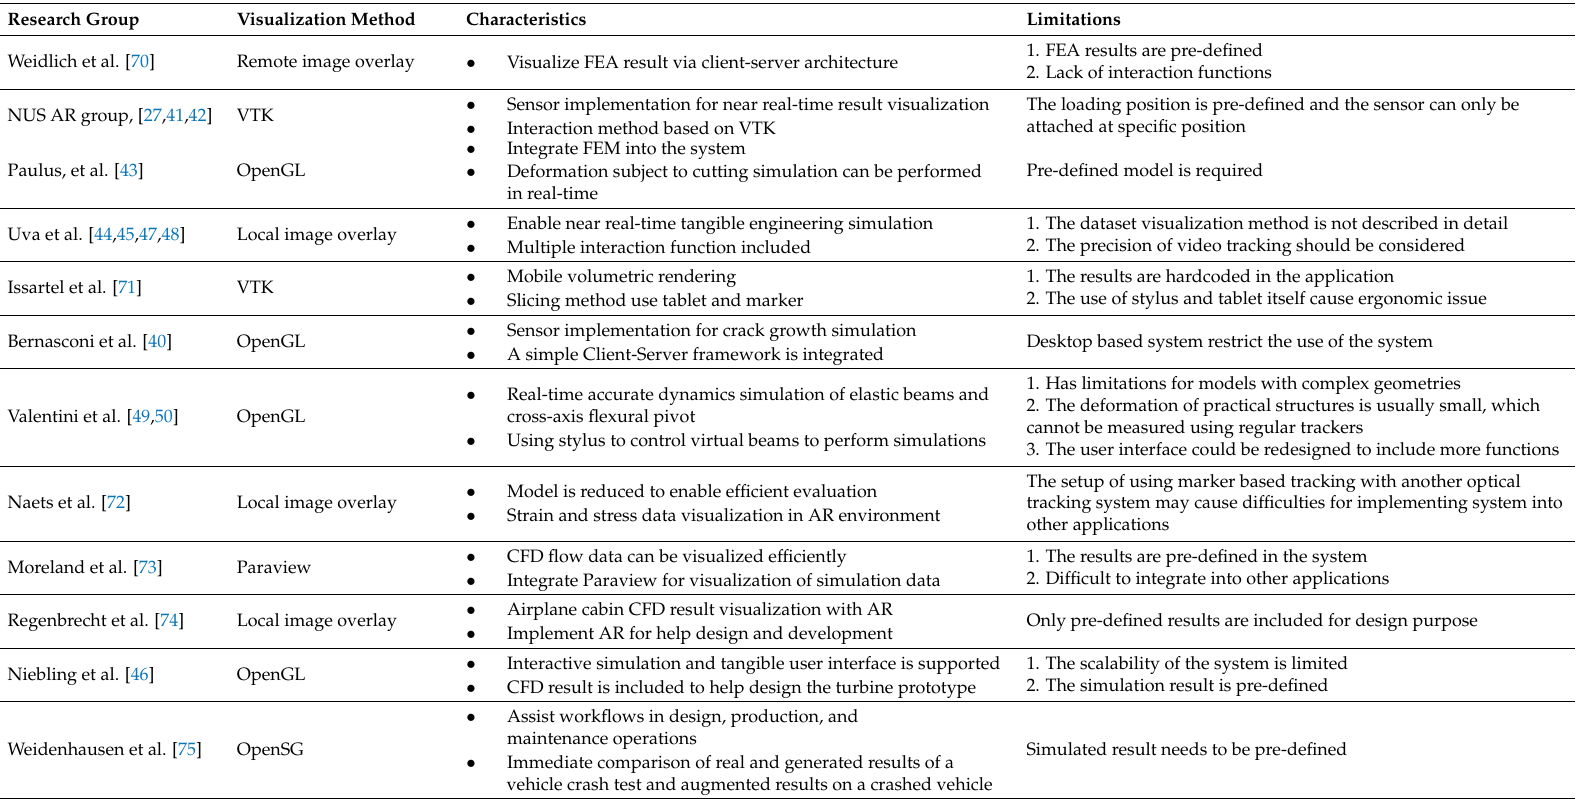
Table 4. Characteristics and limitations of research in mechanical engineering and